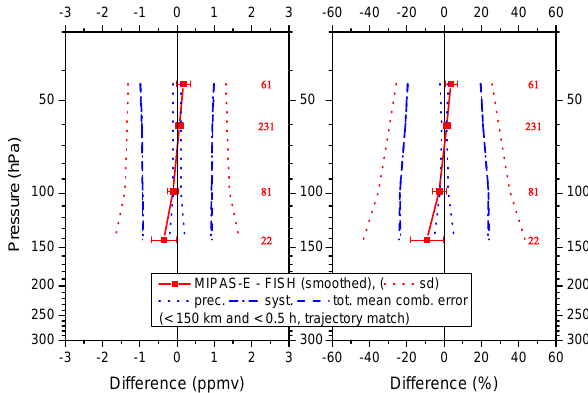
tot. mean comb. error (< 150 km and < 0.5 h, trajectory match) syst. tot. mean comb. error (< 300 km and < 3 h, direct coincidence) Fig. 9. Same as Fig. 8 but for trajectory calculations within a coincidence limit of 150 km and 0.5 h. Fig. 8. Absolute (left) and relative (right) H 2 O differences (red squared lines) between MIPAS-E and the stratospheric hygrometer FISH for all Geophysica flights carried out above Italy and northern Sweden within a direct coincidence limit of 300km and 3h together with mean combined precision (blue dotted lines), systematic (blue dash-dotted lines), and total errors (blue dashed lines) as well as standard deviation (red dotted lines) and the standard error of the mean, plotted as error bars. FISH profiles were smoothed with the averaging kernel of MIPAS-E. Red values (along the right-hand y- axes) indicate the number of collocations at corresponding pressure levels.